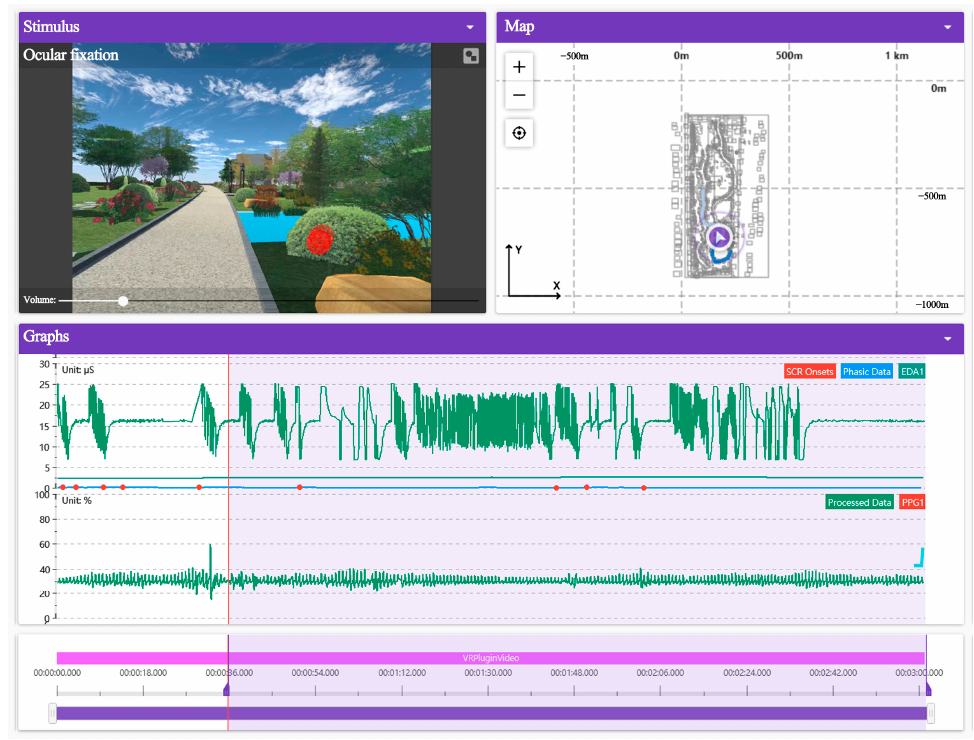
Figure 2. Experimental scene.